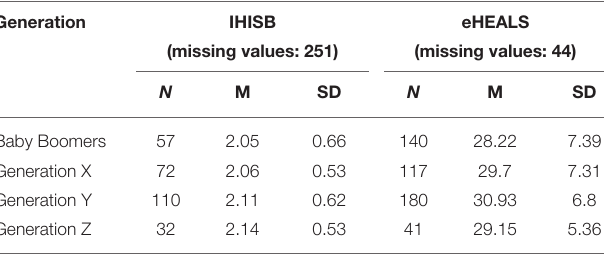
TABLE 2 | Means and Standard deviations of IHISB (a composite score of Internet Health Information Seeking Behavior) and eHEALS scores in generations of Baby boomers, X, Y, and